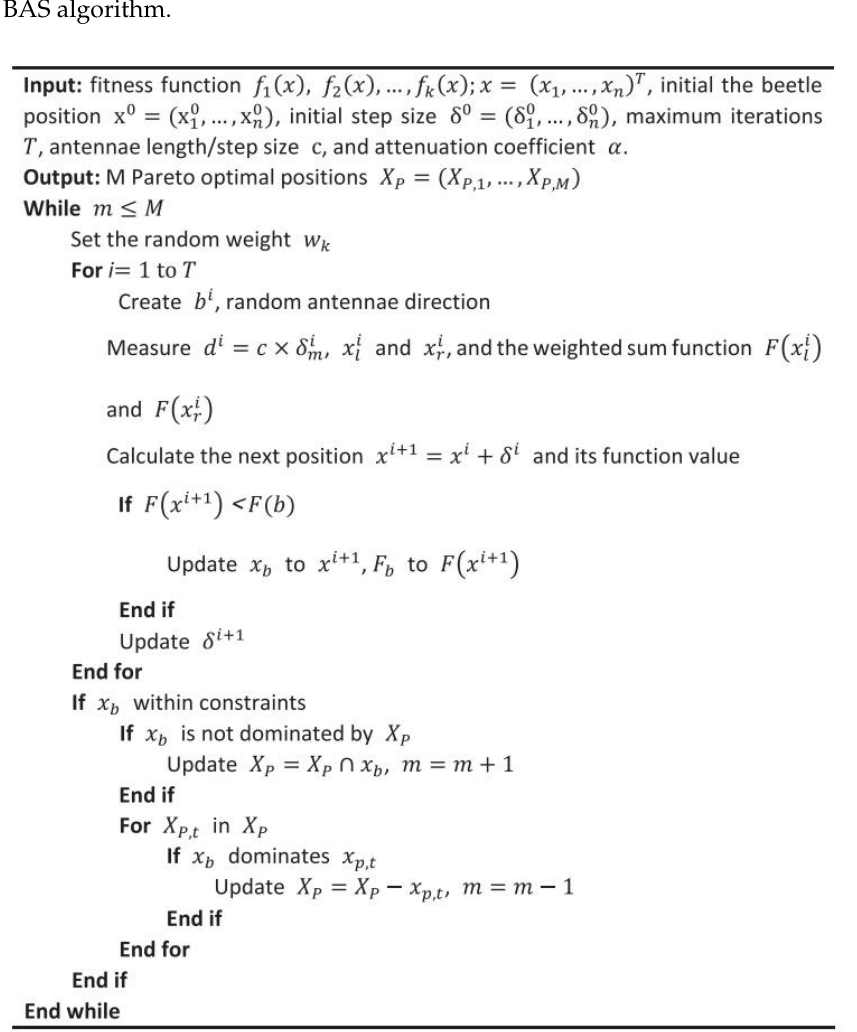
Figure 5. Multi-objective BAS algorithm [57].